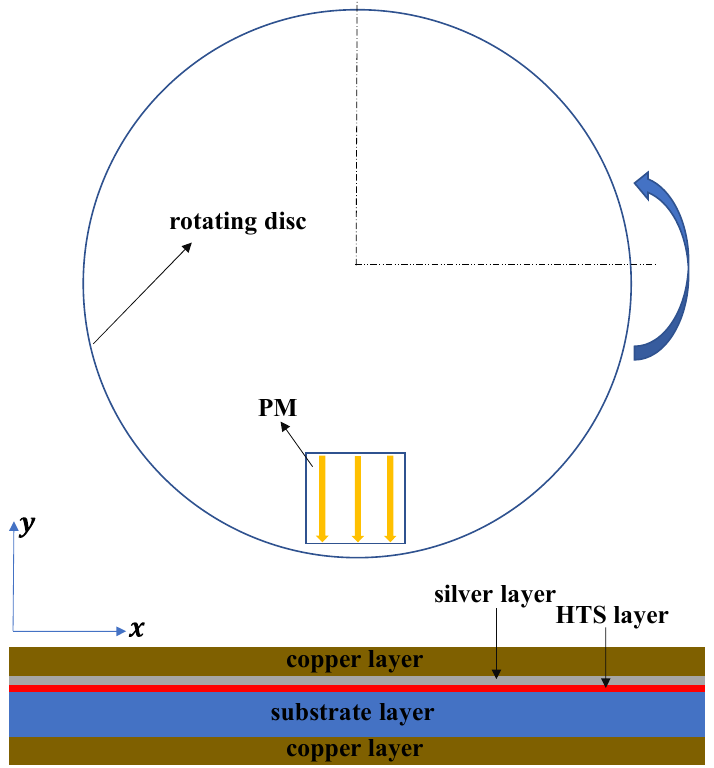
Figure 10. Illustration of the modeling framework for an HTS dynamo (cross section view), and the golden arrows identify the polarization of PM, the blue twisted arrow means the rotating direction of the disc.